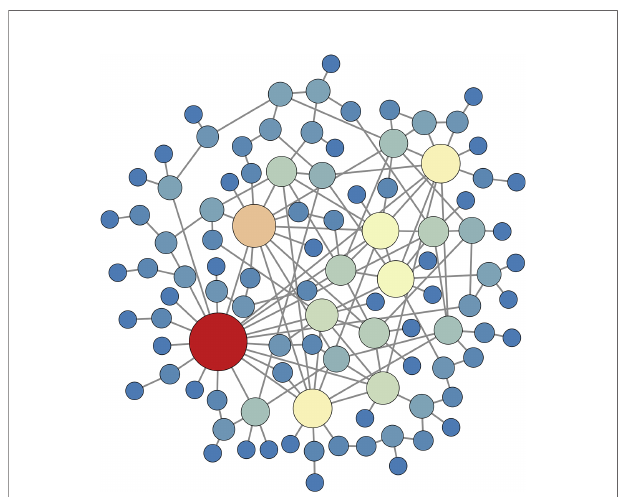
FIGURE 9 | A random network that satis fi es a power law degree distribution with exponent g =2.8 , constructed using a con fi guration model algorithm. Large nodes with hotter colors have high degree. The yellow, orange, and red nodes can be considered to be structural hubs. This structural network is used in simulations for subsequent fi